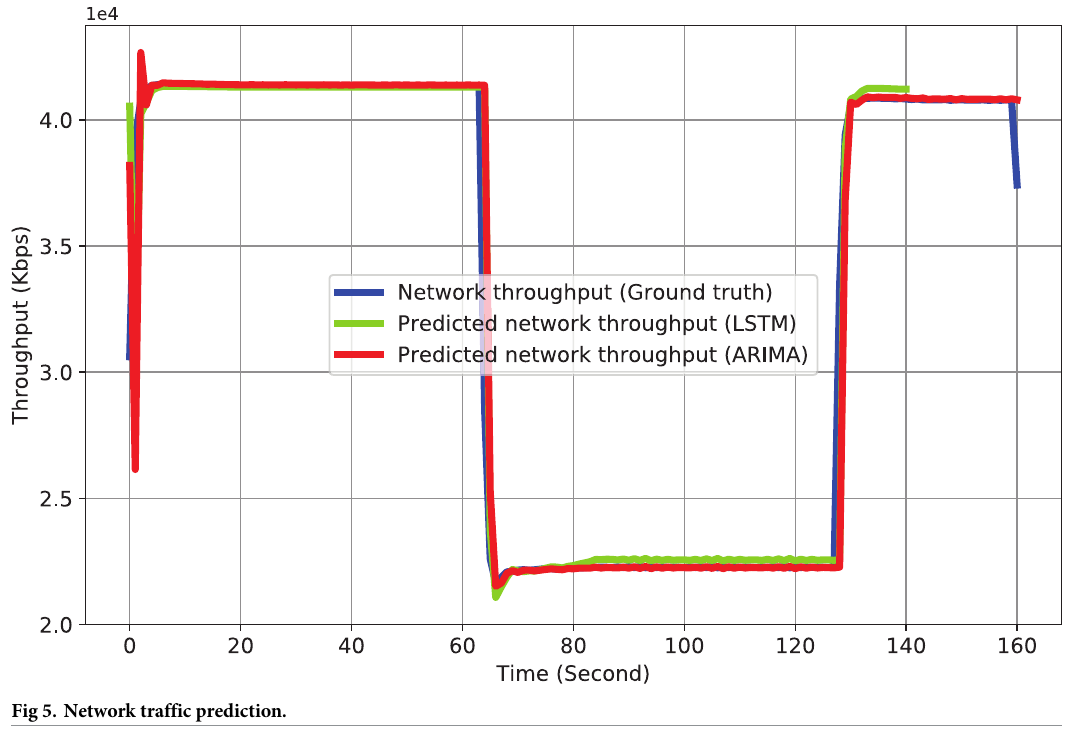
Fig 5. Network traffic prediction.